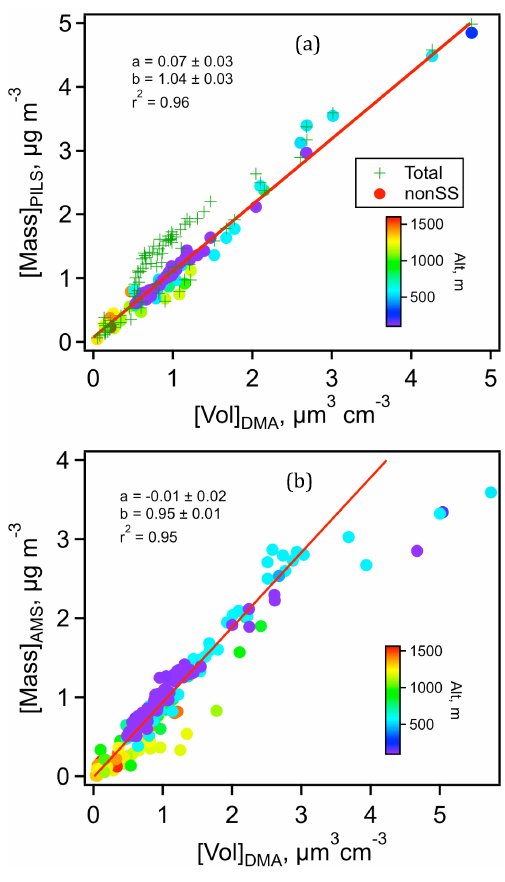
Figure 2. Comparison of aerosol mass concentrations determined using the PILS and the AMS with the aerosol volume concentra- tions calculated from DMA size distributions: (a) mass concen- trations of ionic species from PILS and Org from the AMS with (crosses) and without (solid circles) SSA components: (b) mass concentrations determined using the AMS, normalized to the PILS using nss-SO 2 − . Solid lines are least squares best 4